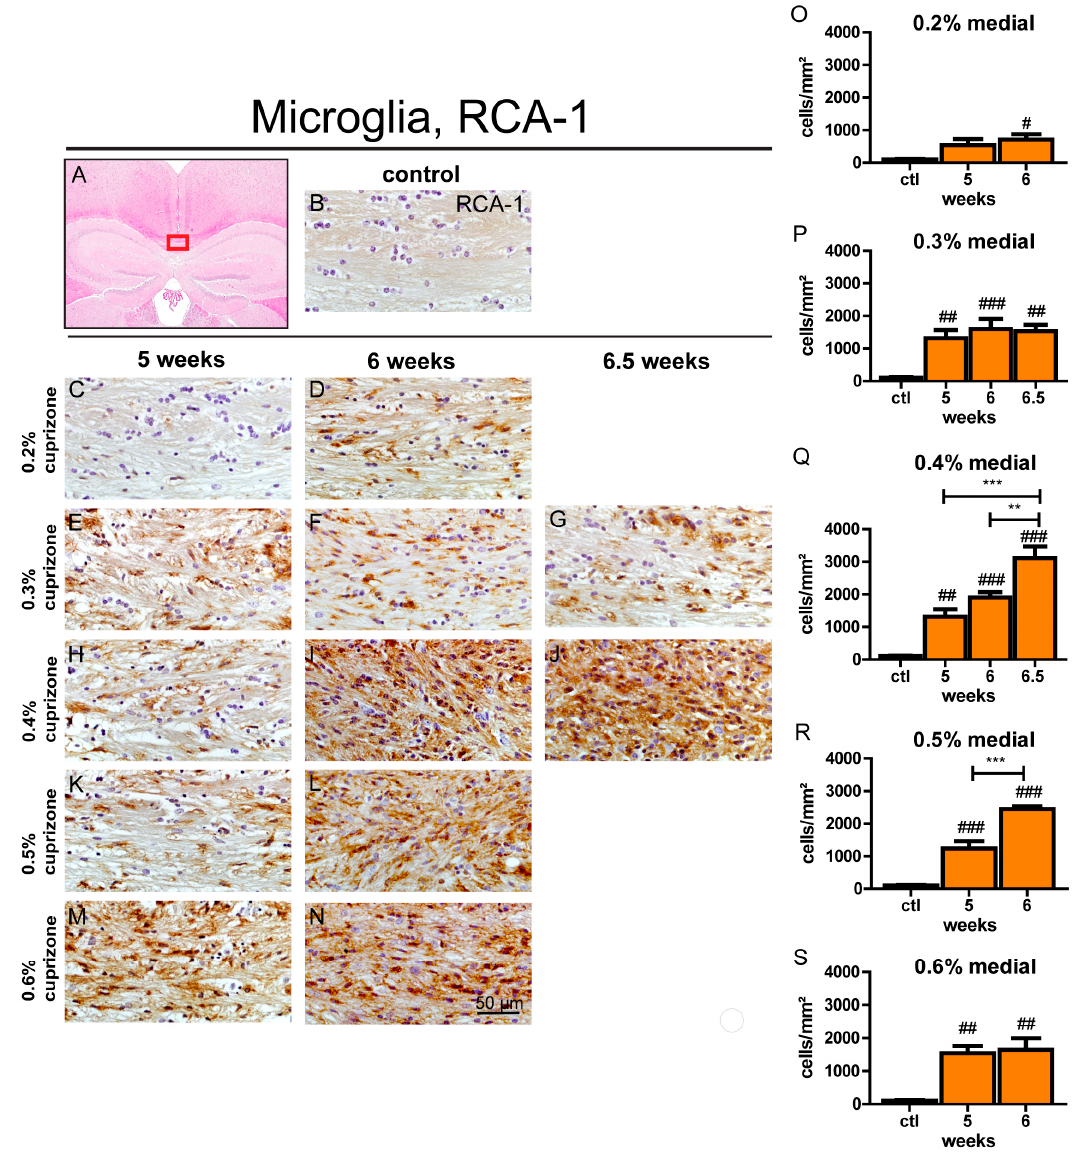
Figure 3. Activation of microglia in the central corpus callosum during cuprizone-induced demyelination in aged mice. The red box in ( A ) displays the medial section of the corpus callosum that was analyzed. Representative pictures ( C – N ) of RCA-1-stained brain sections show accumulation of activated microglia during the course of demyelination in the midline of the corpus callosum of aged mice after cuprizone treatment with various doses (0.2–0.6% cuprizone) for di ff erent feeding periods (5, 6, or 6.5 weeks). An exemplary brain section of a control animal stained for RCA-1 is shown in ( B ). Graphs depict the amount of RCA-1-positive cells / mm 2 per time point in the midline of the corpus callosum in aged animals ( O – S ). Bars represent mean + SEM. E ff ects between di ff erent investigated time points are indicated by asterisks and e ff ects in comparison to control are indicated by hash marks (* / # p < 0.05; ** / ## p < 0.01; *** / ### p < 0.001). Ctl. = control; 5, 6, or 6.5 weeks = feeding period of cuprizone for respective duration. N = 5–6 animals per